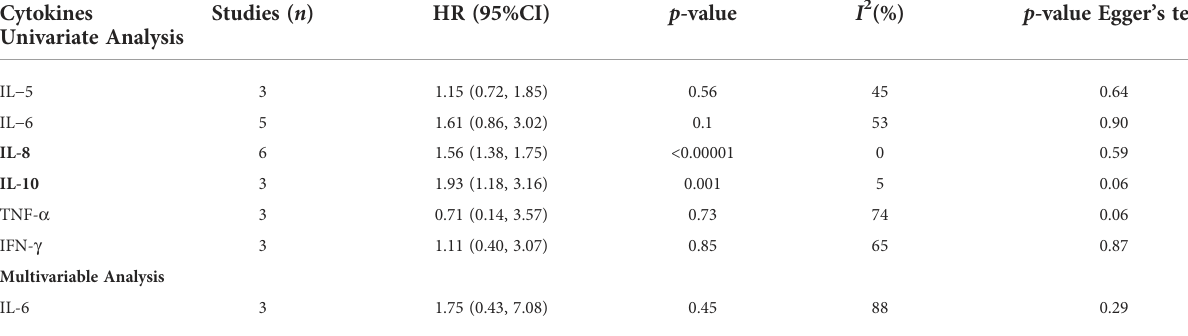
TABLE 4 Meta-analysis investigated the association between cytokines and